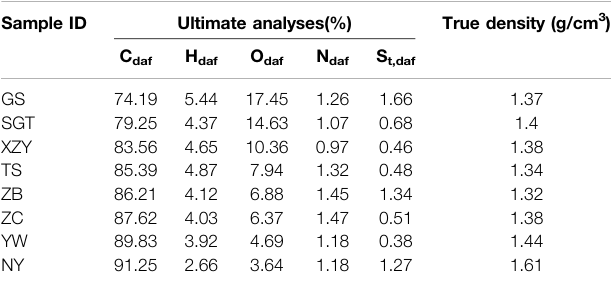
TABLE 2 | The ultimate analyses and true density of coal